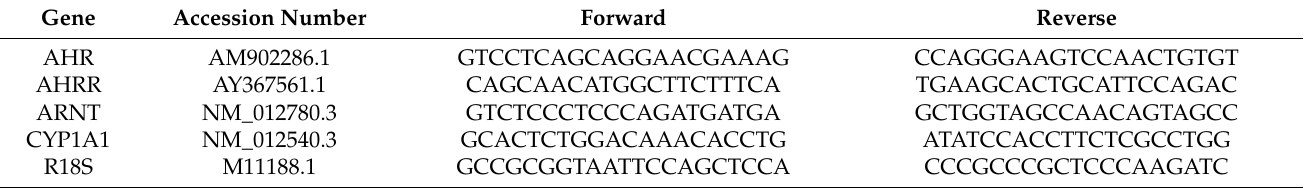
Table 1. Primer sequences used for qPCR